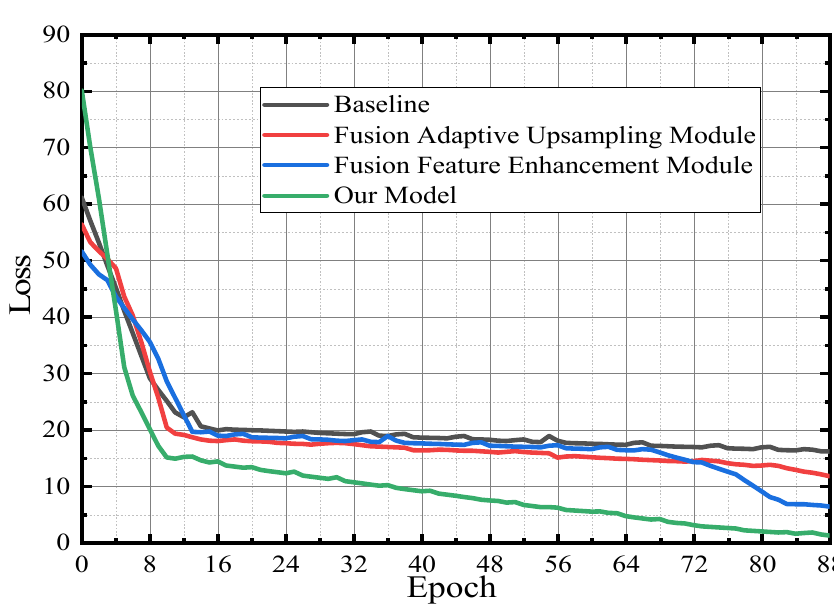
Figure 14. Model verification—loss function graph.